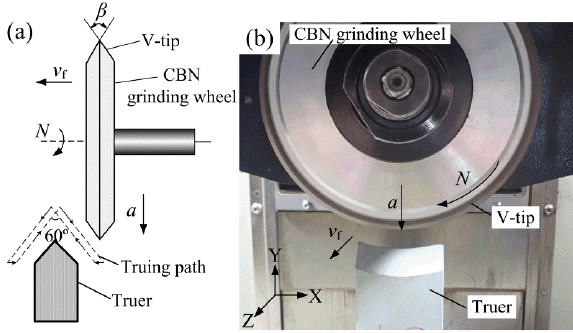
Figure 4. The precision truing of the V-tip CBN grinding wheel: ( a ) V-tip truing principle; ( b ) truing photo.